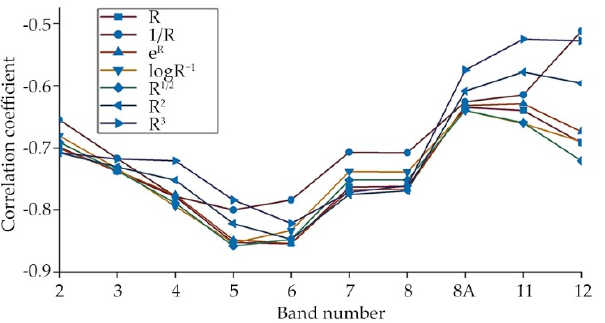
Figure 4. Correlation statistics of organic matter content and reflectivity (R represents reflectance spectra, 1/R represents inverted transformation, e R is exponential transformation, logR − 1 is logarithm the reciprocal of reflectance, R 1/2 is square-root transformation, R 2 is square transformation, R 3 is cubic transformation).